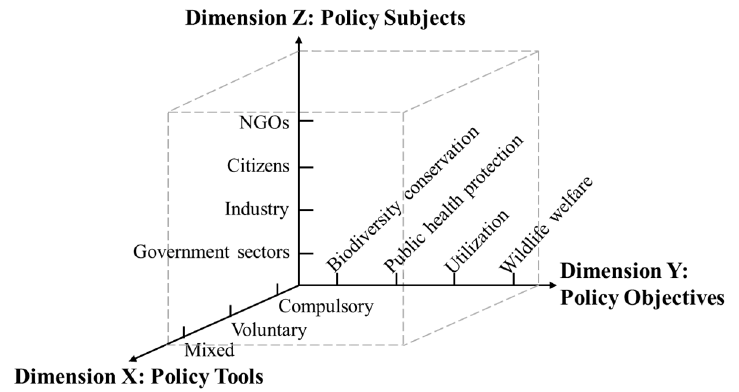
Figure 1. Three-dimensional Analytical Framework of China’s Wildlife Management Policy Documents.